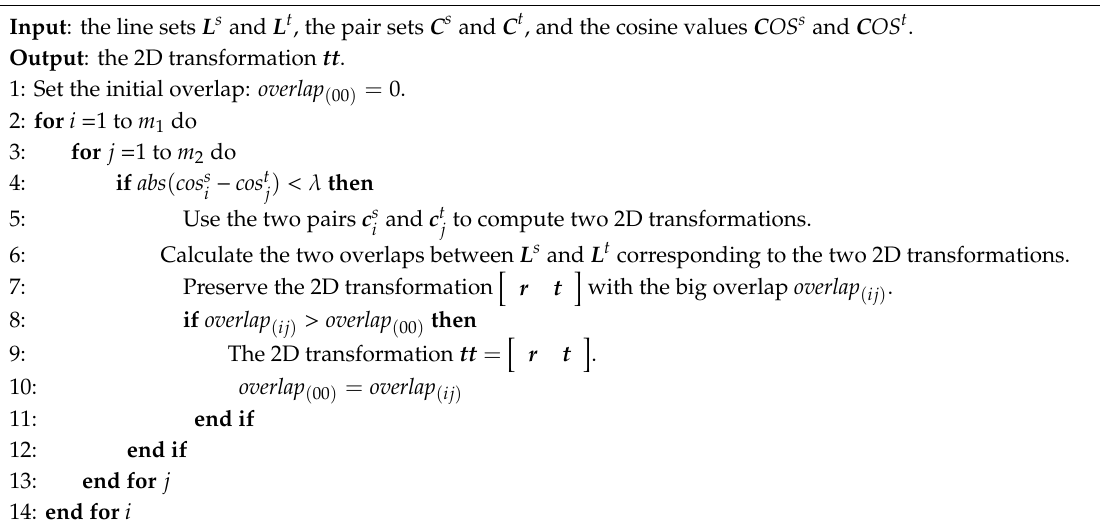
Algorithm 2 : 2D transformation